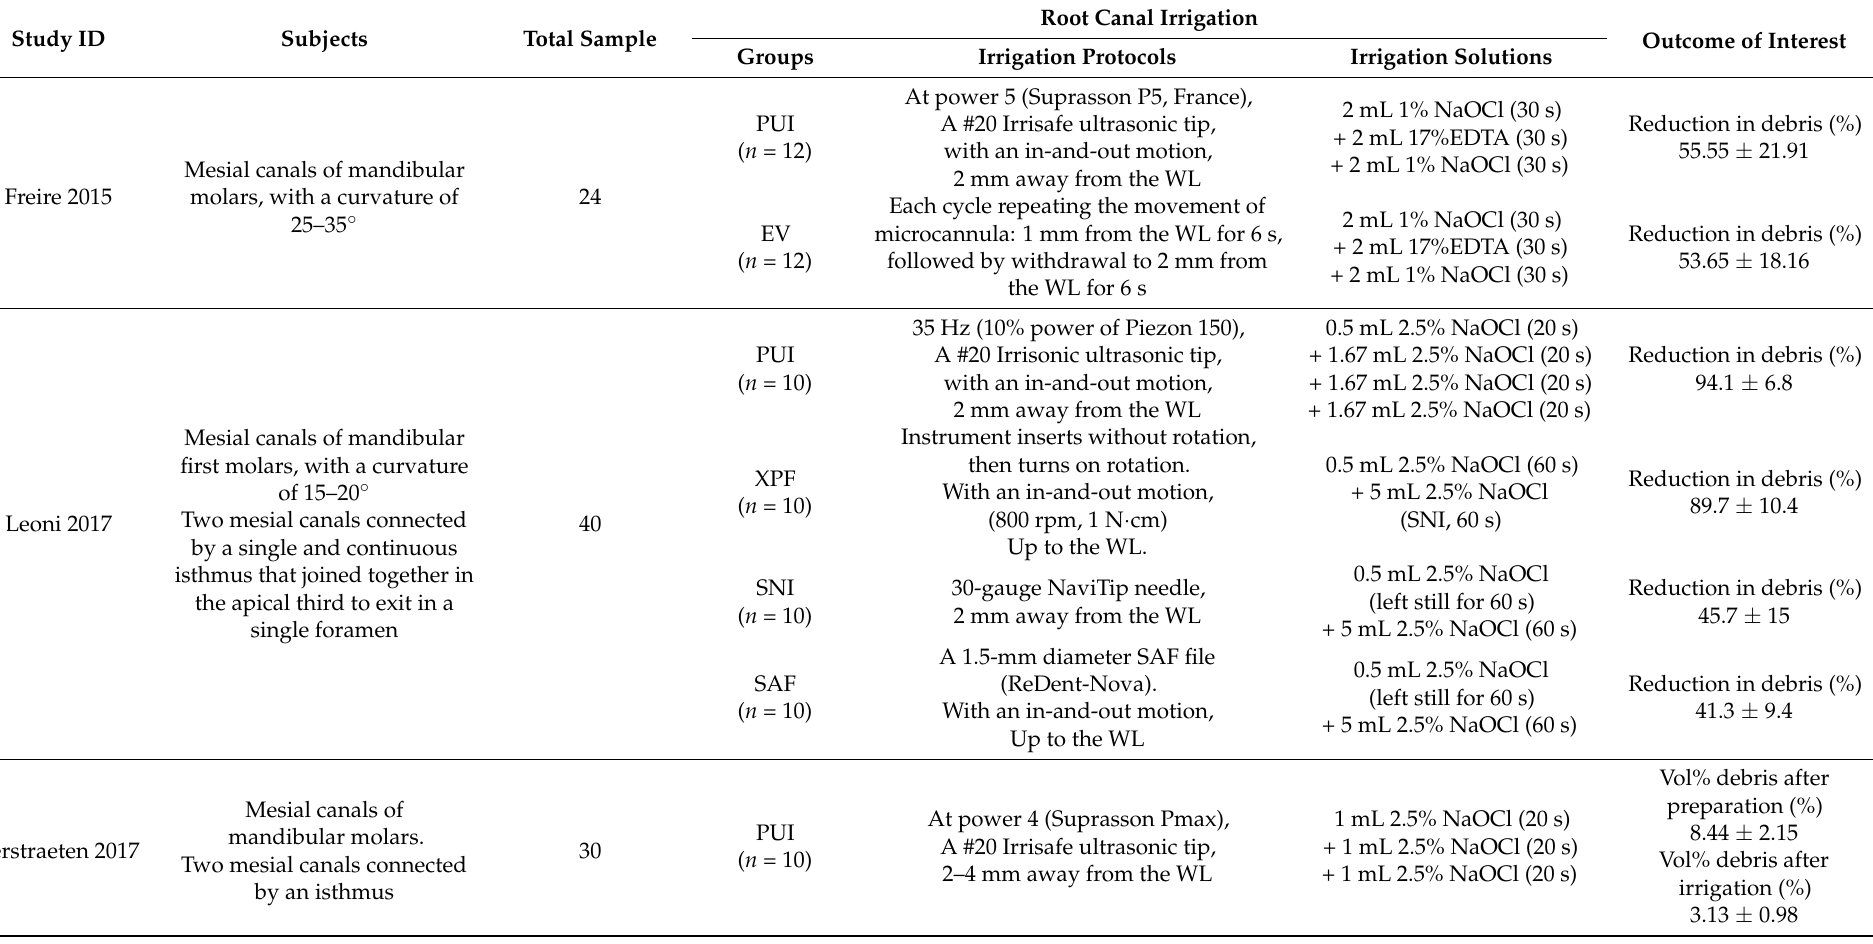
Table 1. Main characteristics of included